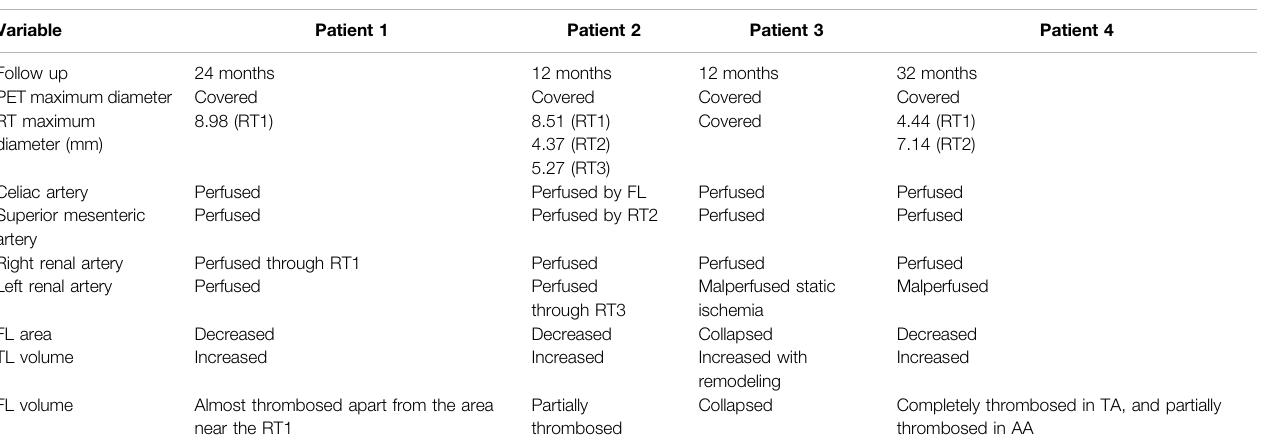
TABLE 4 | Geometric analysis for the four kind of aortic dissection post-TEVAR. Variable